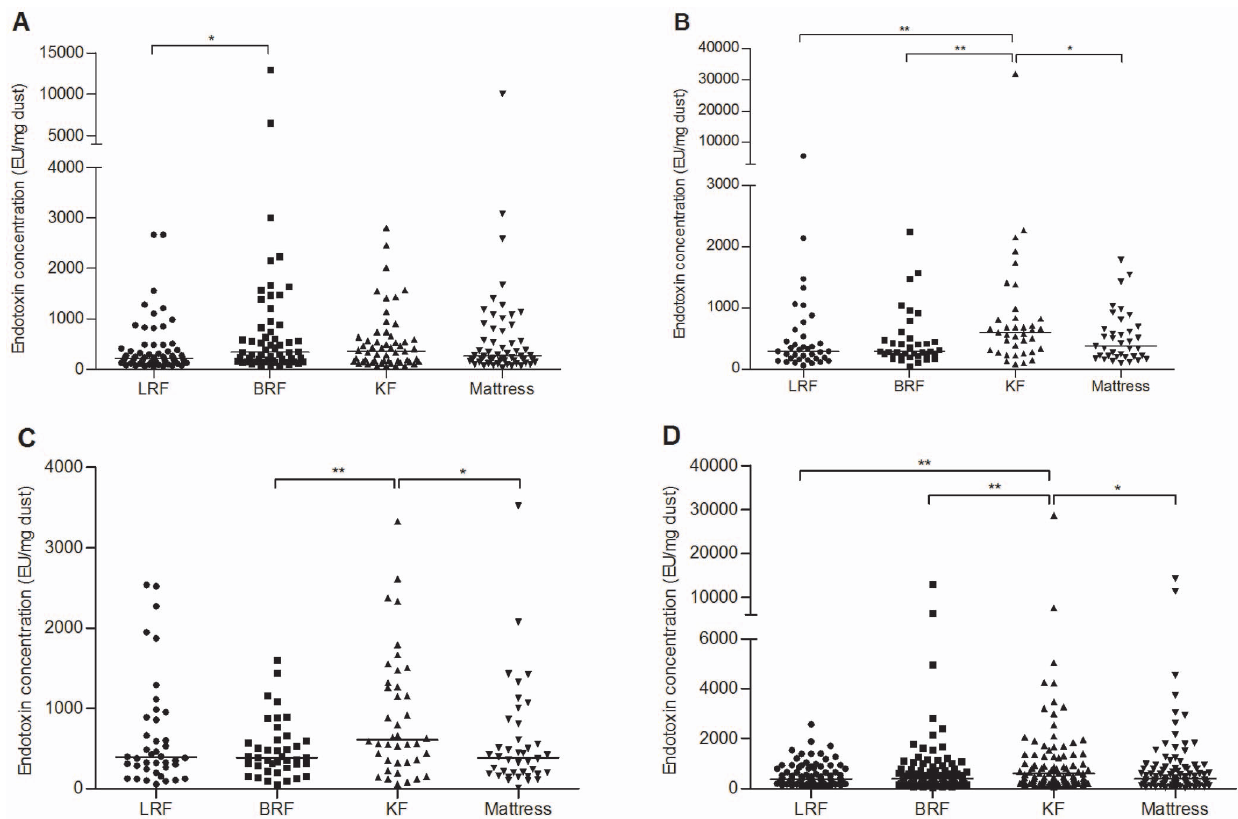
Figure 3. Endotoxin concentrations in dust samples of different locations of children’s homes. (A) asthma group; (B) allergic rhinitis group; (C) AS + AR group; (D) control group. LRF: living room floor; BRF: bedroom floor; KF: kitchen floor. –: median. *: p , 0.05; **: p ,